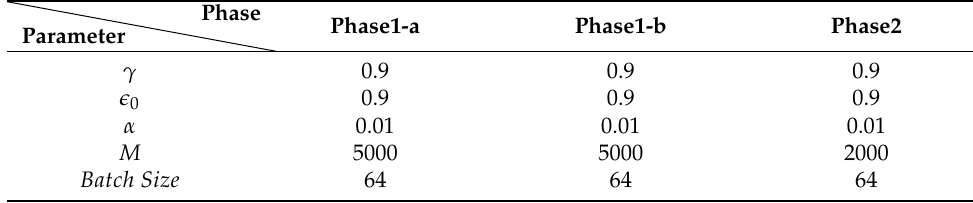
Table 3. Some hyper-parameters of MS-DDQN.